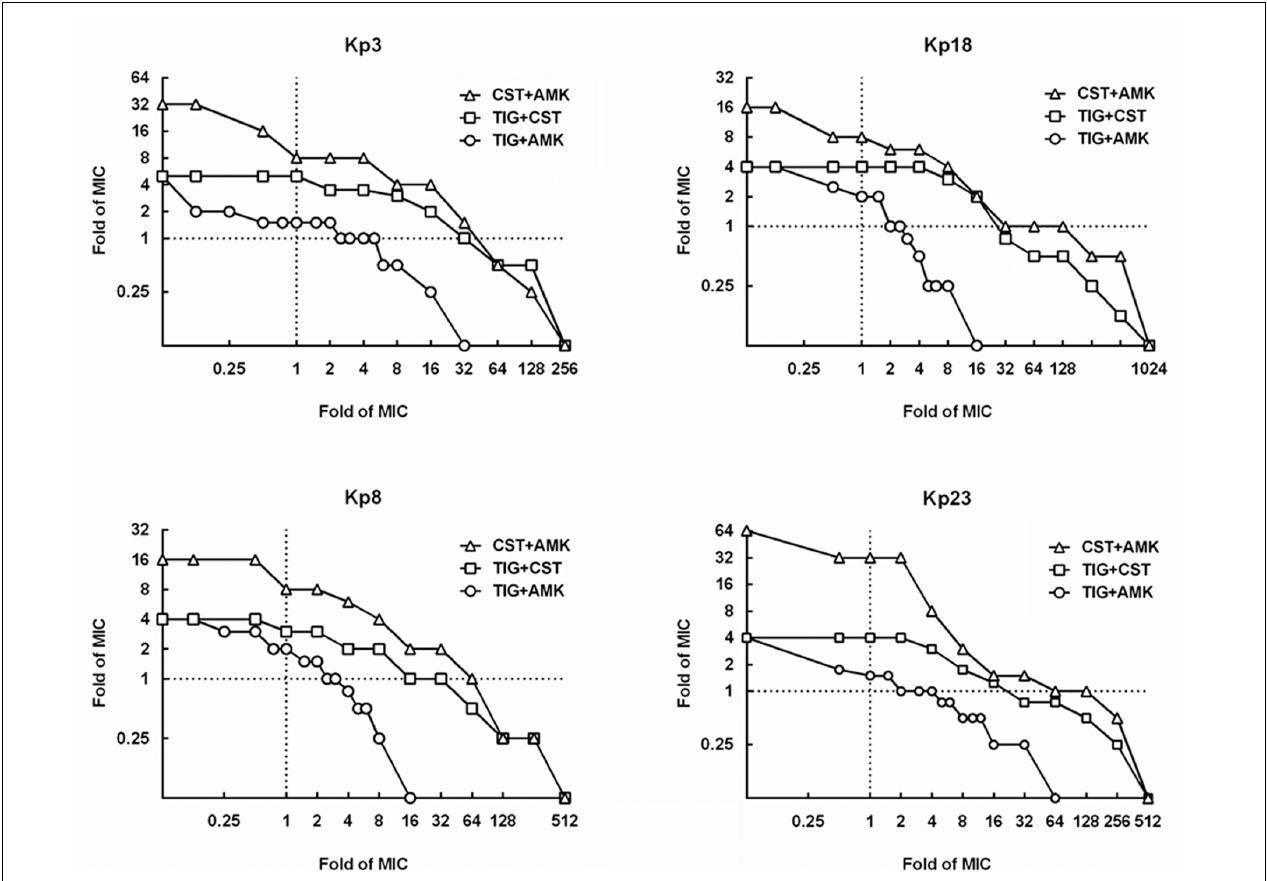
FIGURE 4 | Mutant selection window of drug combinations (MSW combination ) for four KPC-producing K. pneumoniae strains. MSW combination can be measured as the area that extends from the MPC curve (curves with symbols) to the MIC lines (dashed line). TIG, tigecycline; CST, colistin; AMK,